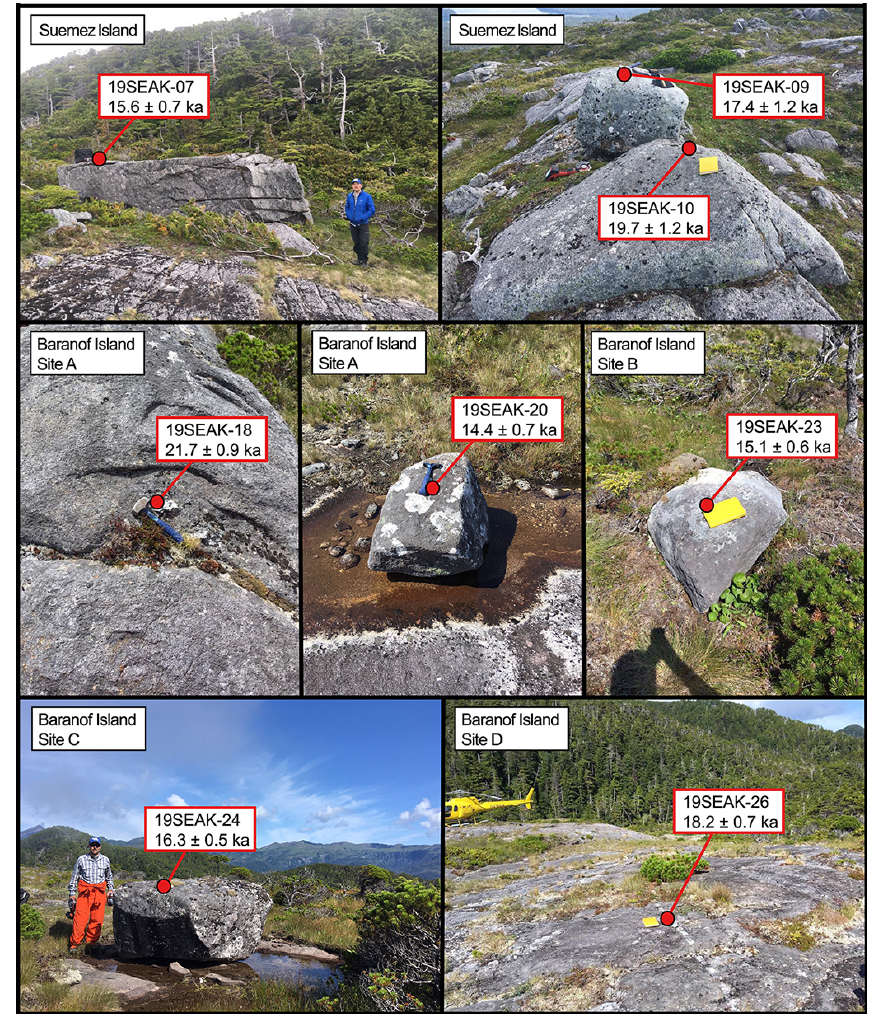
Figure 3. Sample photos from 2019 field season. All 10 Be ages shown with 1 σ internal